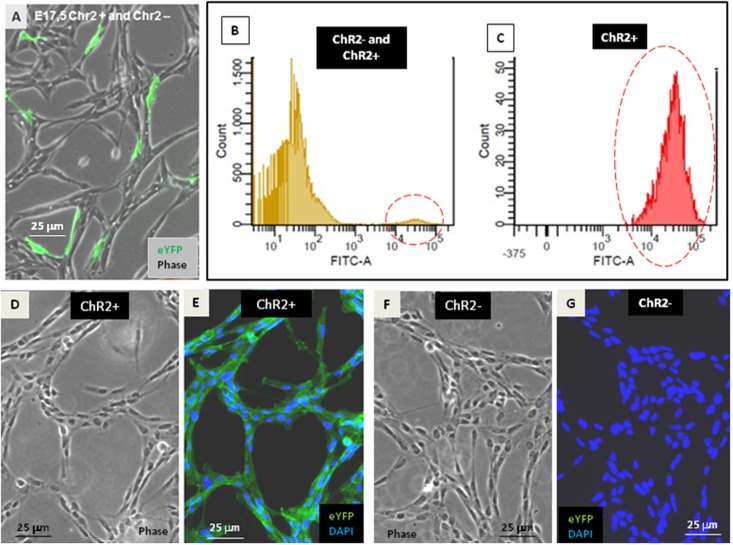
Establishment of ChR2-expressing and non-expressing cell populations. After transfection with pTurbo-Cre plasmid, less than 5% of RGl-cells expressed the ChR2-eYFP fused protein as it was shown by fluorescent microscopy (A) and by cytometric analysis (B,C; see also Supplementary Material S2). FACS-separated ChR2-eYFP expressing (ChR2+; D,E) and ChR2-eYFP non-expressing (ChR2-; F,G) cells grown in separate cultures displayed similar cell shape.